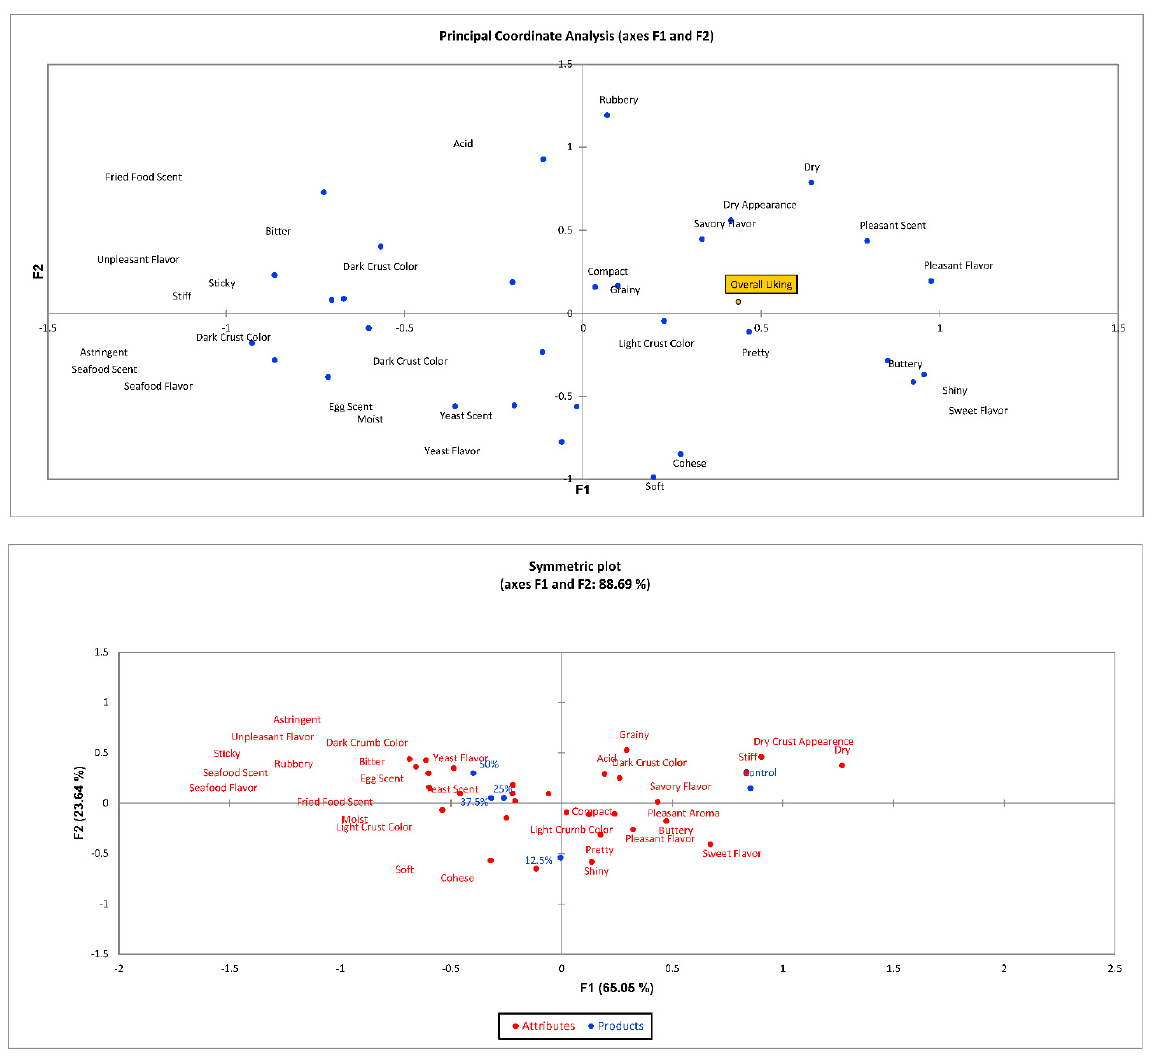
Figure 3. Sensory descriptive map resulting from Correspondence Analysis performed on the CATA data ( n = 43). Table 3. Absolute frequencies of sensory attributes checked for the different Amorphophallus